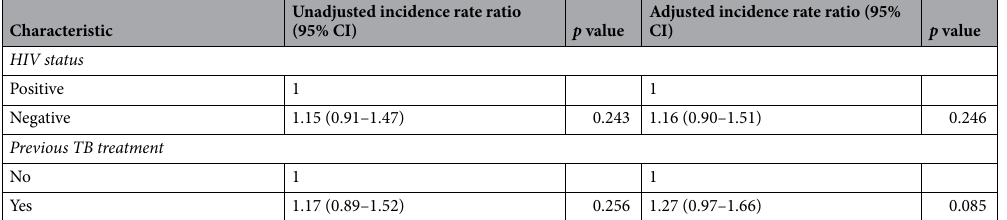
Table 4. Multivariable Poisson regression models for factors associated with TB cure, loss to follow-up and treatment success.